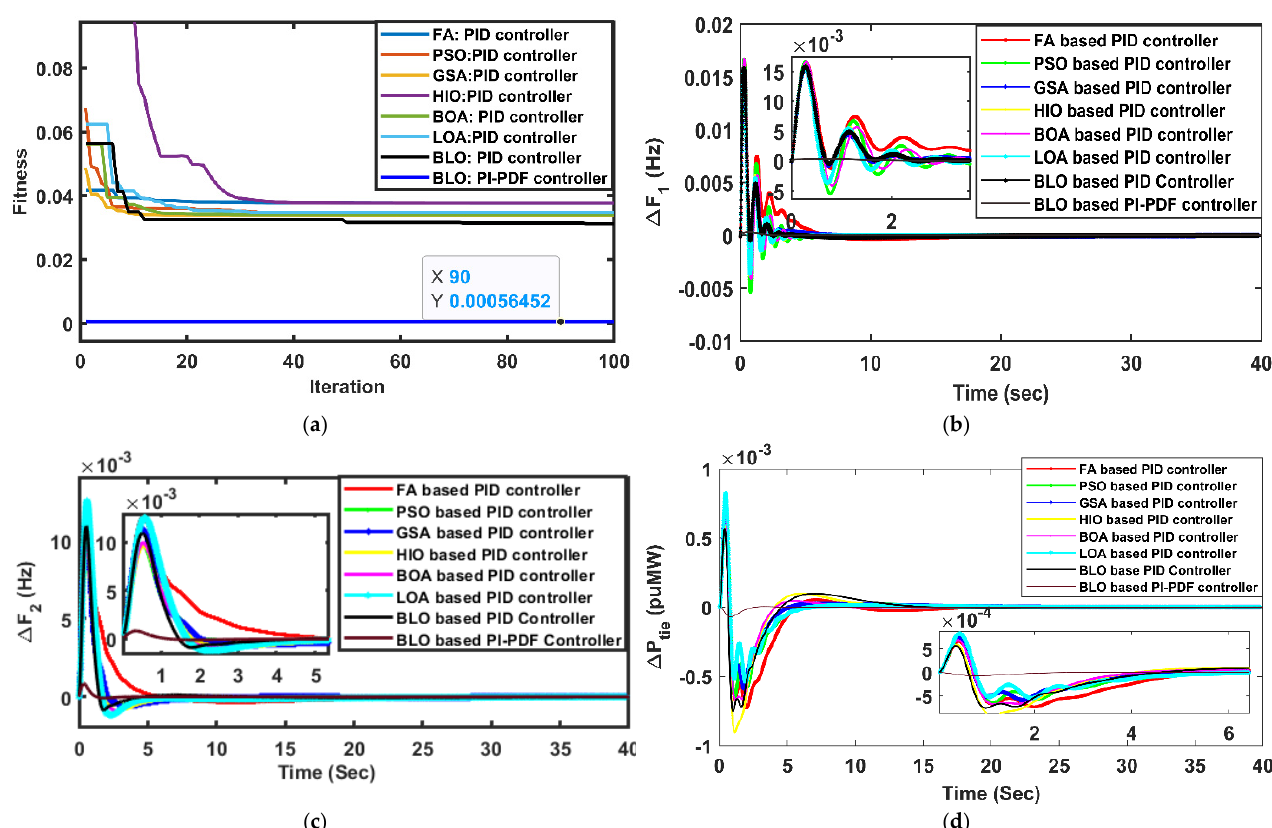
Figure 6. Dynamic response of power system for scenario-II: ( a ) Convergence characteristics, ( b ) Frequency response of area-1, ( c ) Frequency response of area-2, and ( d ) Tie-line power response.